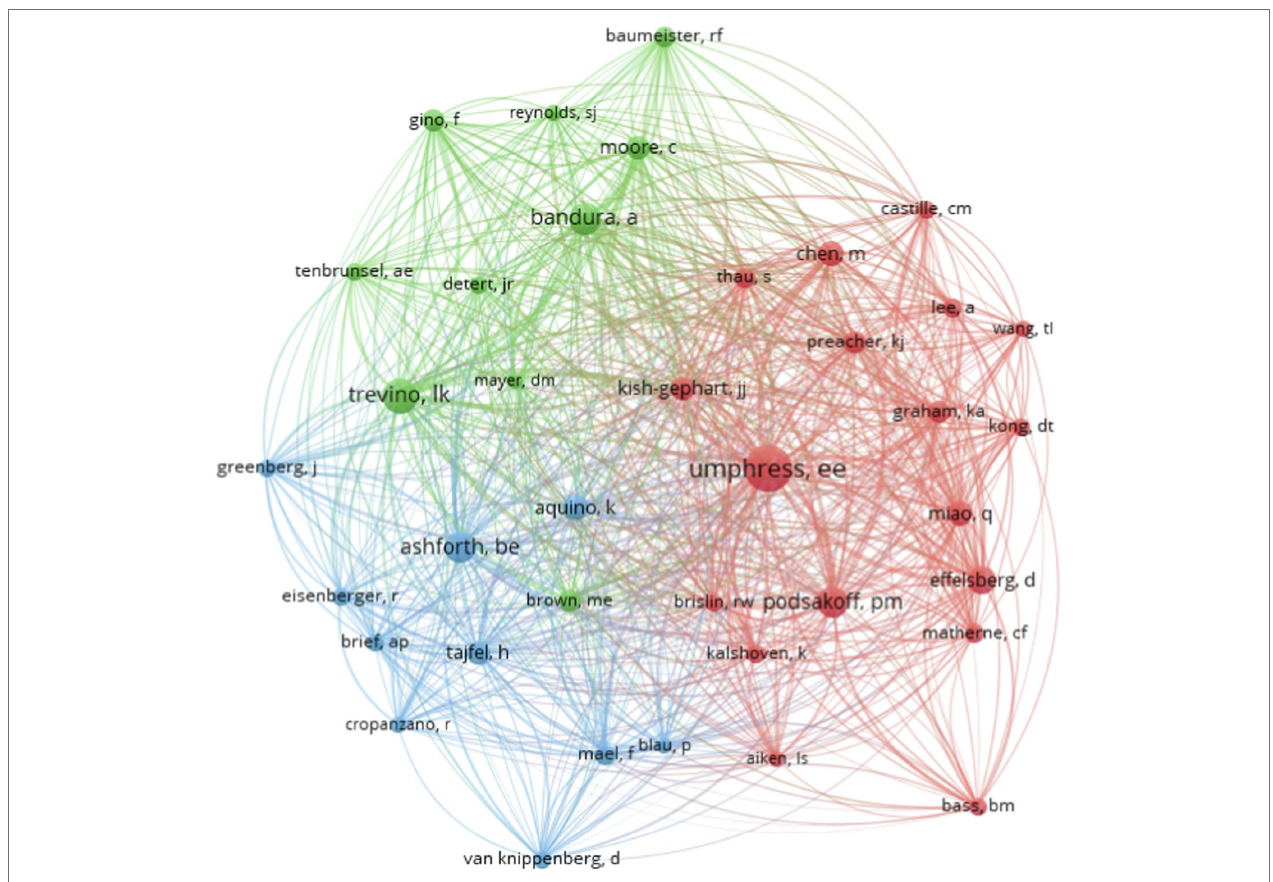
FIGURE 4 | Co-citation network of the most cited authors in UPB